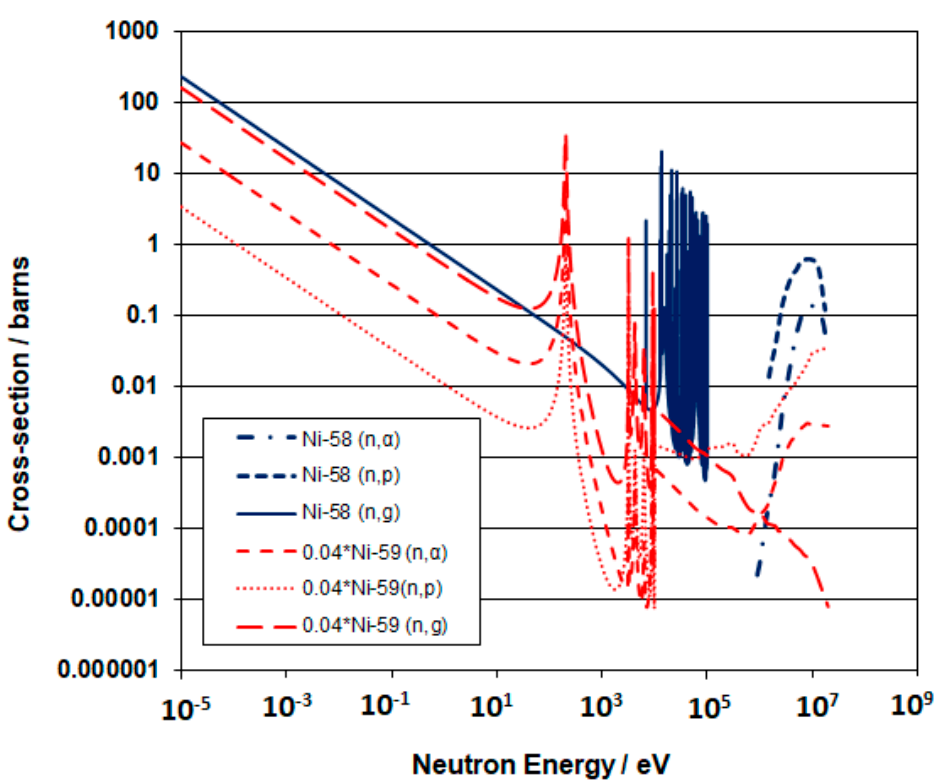
Figure 4. 59 Ni and 58 Ni (n, γ ), (n, p) and (n, α ) reaction cross sections as a function of neutron energy. The 59 Ni cross sections have been scaled by a factor of 0.04, which is the 59 Ni content relative to the parent 58 Ni after about five years of operation in the core of a CANDU reactor. Metals 2022 , 12 , x FOR PEER REVIEW